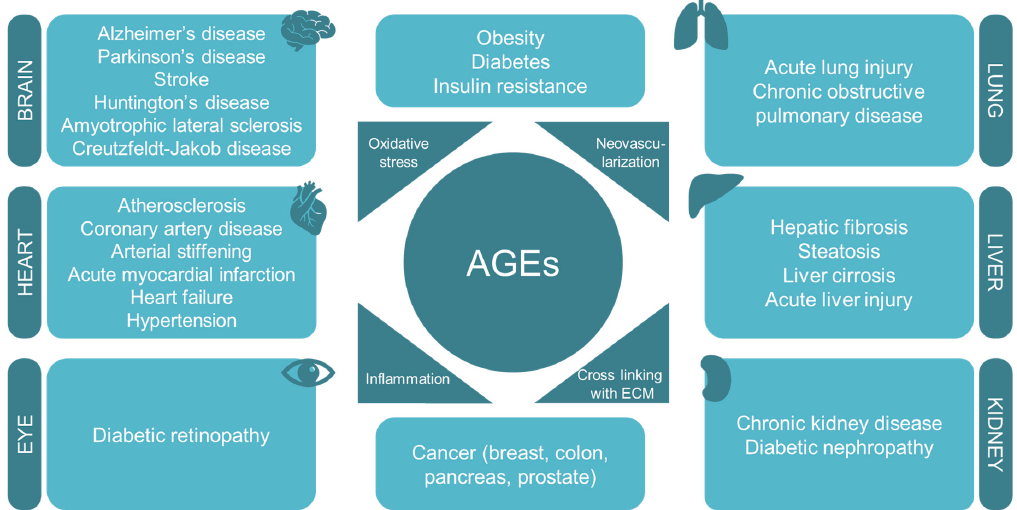
Figure 3. AGEs are involved in the pathogenesis of several diet-related diseases and age-associated diseases by interfering with oxidative stress, neovascularization, inflammation, and cross-linking with the extracellular matrix.